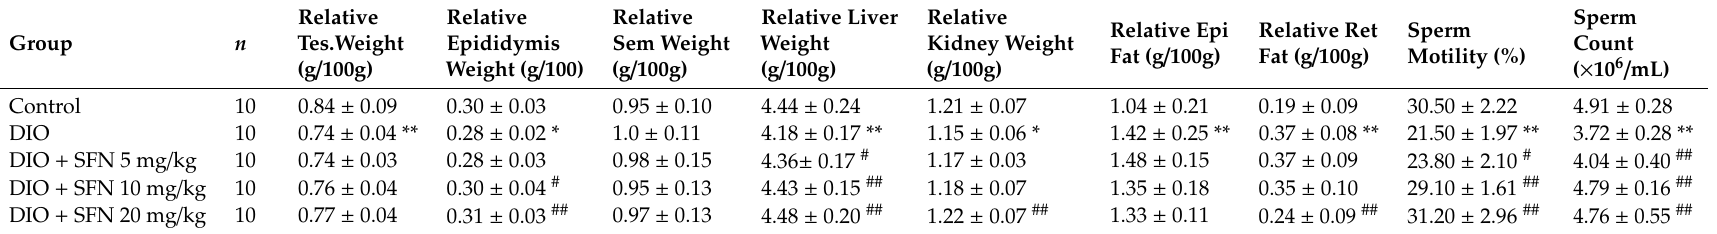
Table 1. E ff ects of SFN on reproductive organs index and sperm characteristics in obese mice (X ±